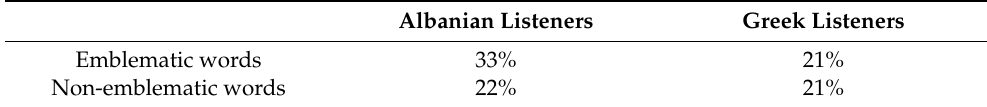
Table 4. The percentage of each non-SMG target was identified as being produced by a talker from Albania by listener ethnicity and target emblematicity